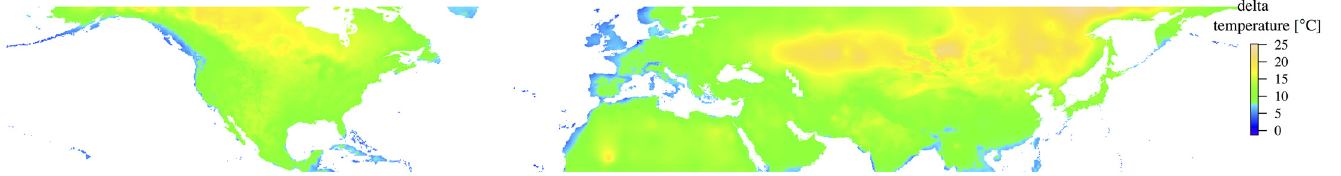
Fig 4. Differences between average temperatures in early spring (March) and the maximum temperatures the following month (April). The temperatures experienced during the adult stage of D . melanogaster in nature may differ from the temperatures experienced during development. To quantify these temporal changes in temperature, we calculated the differences between average temperatures in March and the maximum temperatures in April in the Northern hemisphere (delta temperature (°C)). Temperature data was obtained from WorldClim and are interpolations of data from 1950 – 2000 [53]. The map was produced with the raster package in R vers. 2.2 – 5